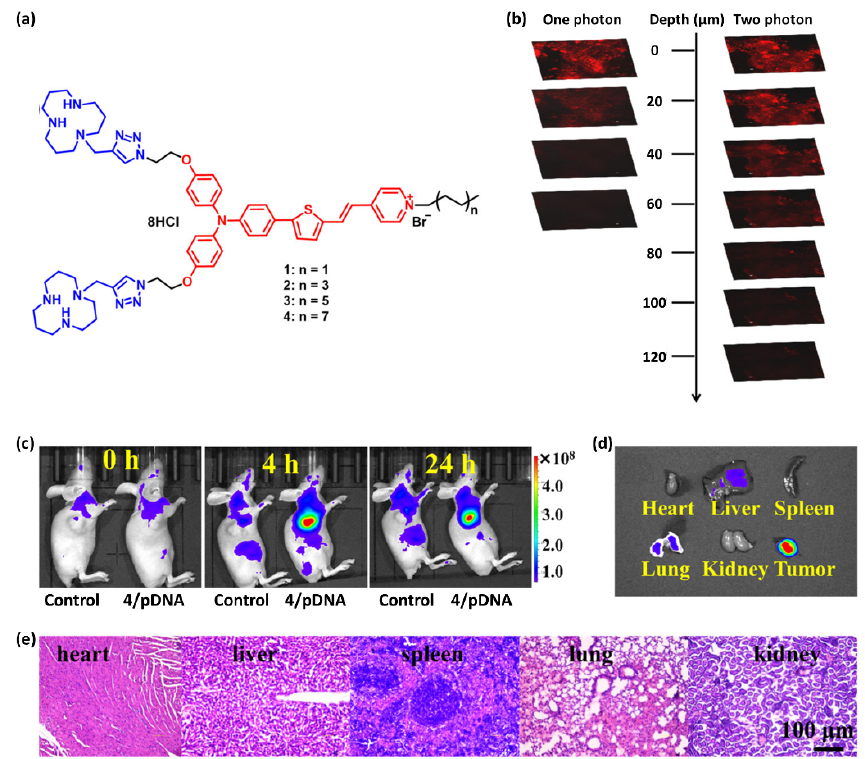
Figure 10. ( a ) Structures of probe molecules consisting of three parts: two polar [12]aneN 3 -triazole heads (blue), a luminogen core (red), and a long hydrophobic tail (black). ( b ) Ex vivo one-photon or two-photon images of the tumor tissue injected with [12]aneN 3 -modified TPA derivatives/pUC18 DNA. ( c ) In vivo imaging at different time points after intratumor injection with [12]aneN 3 -modified TPA derivatives/pUC18 DNA. ( d ) Ex vivo biodistribution of various organs and tumor tissue from mice 24 h post-injection with [12]aneN 3 -modified TPA derivatives/pUC18 DNA. ( e ) Major organs harvested from the mice after being intratumorally injected with [12]aneN 3 -modified TPA derivatives/pUC18 DNA for 21 days. Reprinted with permission from Ref. [234] . Copyright 2021, American Chemical Society.